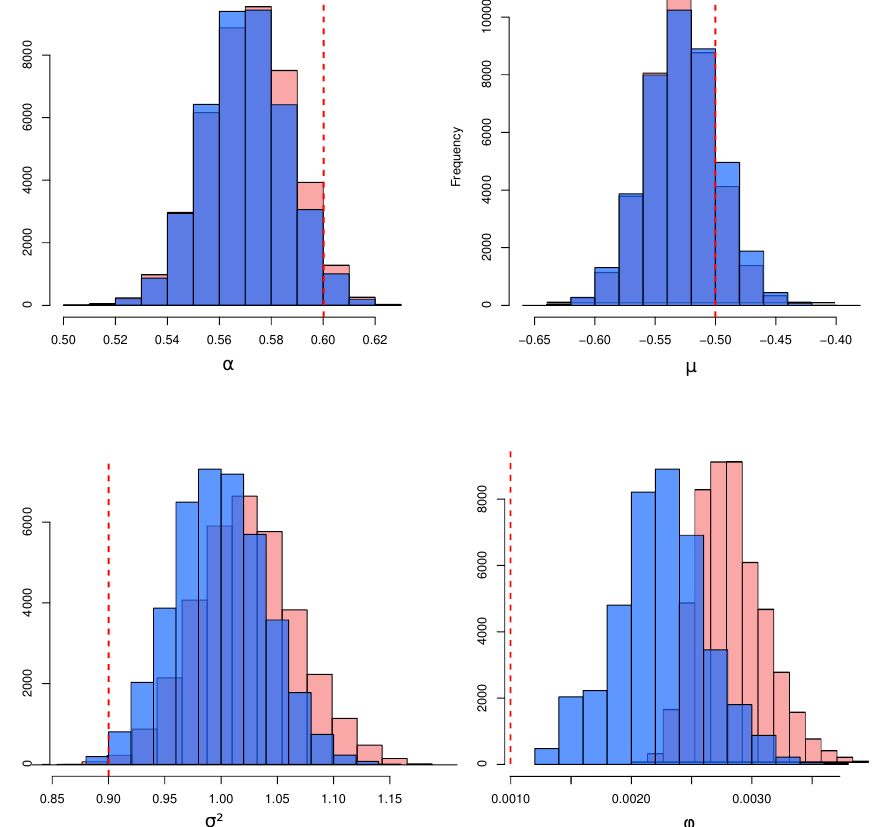
Figure 5. Histograms of the draws of the process-level parameters ( α , µ , σ 2 , φ ) for the experiment with only time-uncertain proxies. Blue histograms: results using BARCAST+AMS. Red histograms: results using random age model selection. Vertical red lines denote the true parameter values from Table